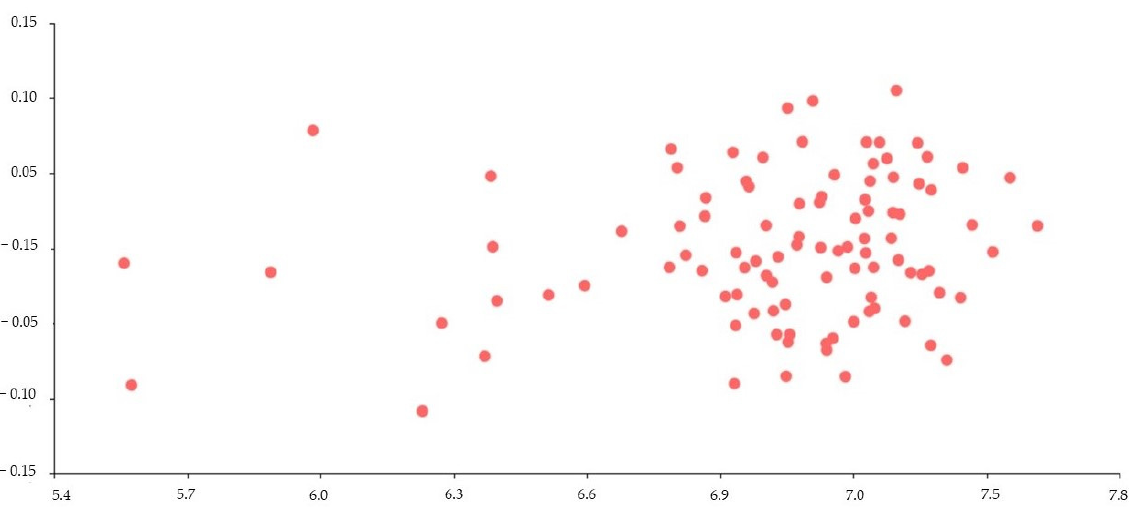
Figure 3. Multivariate regression using age in months (log-transformed values) as independent variable ( X -axis) and the cephalic profile (defined by 14 semi-landmarks) as a dependent variable ( Y -axis). Note: Each point represents an animal. A statistically significant correlation was reflected (R 2 = 0.014; Wilks’ λ = 0.279; F 28,70 = 6.46; p ( regr ) << 0.0001).